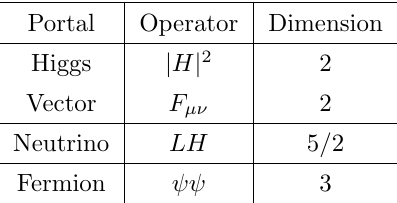
Table 1 . Portal operators in the Standard Model, ordered by their mass